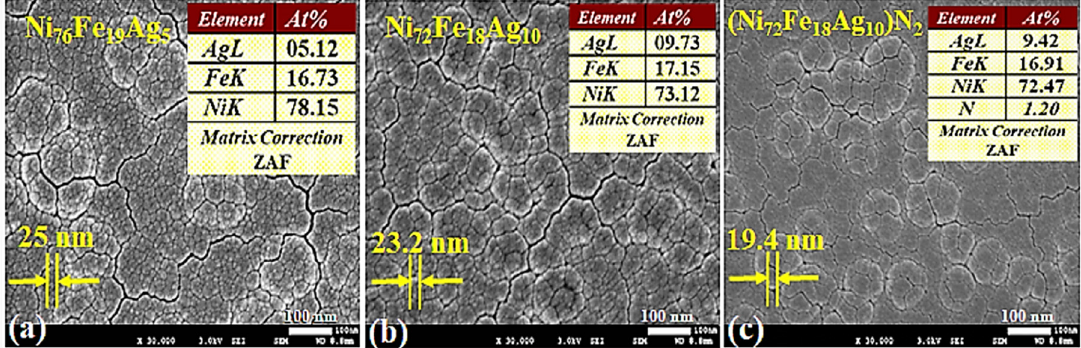
Figure 10. Surface morphology of nanostructured Ag-doped permalloy thin films deposited at 115 W. ( a ) Ni 76 Fe 19 Ag 5 ; ( b ) Ni ( a ) Ni 76 Fe 19 Ag 5 ; ( b ) Ni 72 Fe 18 Ag 10 ;and ( c ) (Ni 72 Fe 18 Ag 10 )N 2